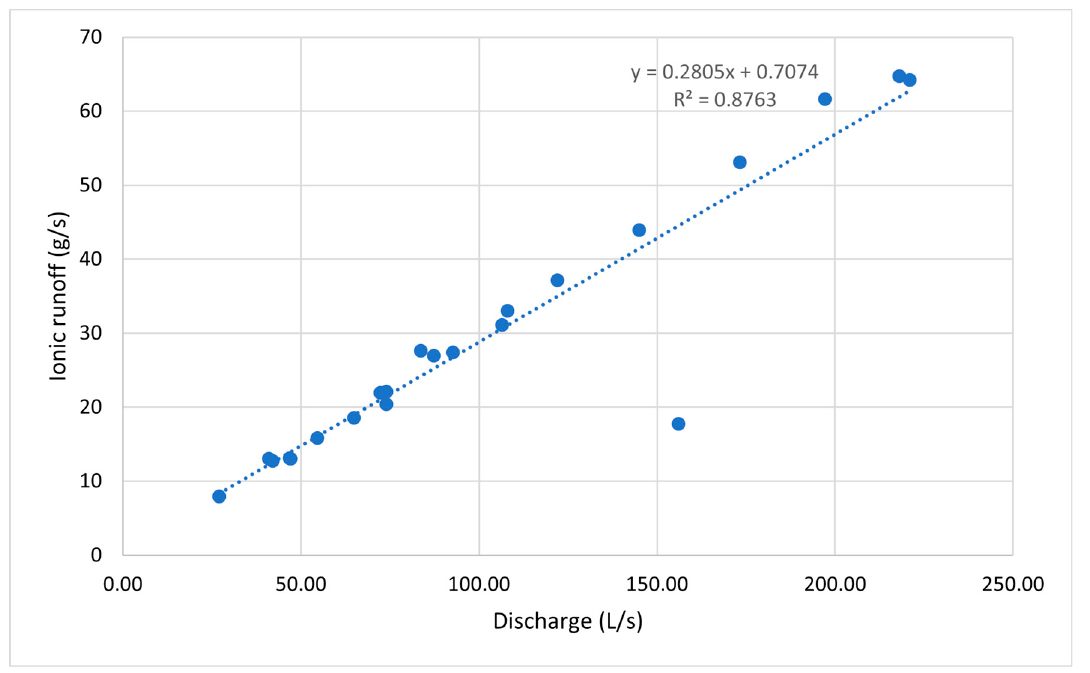
Figure 6. Correlation between ionic runoff and discharge of Skalistý potok Spring. Table 1. Average discharge, TDS and ionic runoff overview based on measurements and available data.